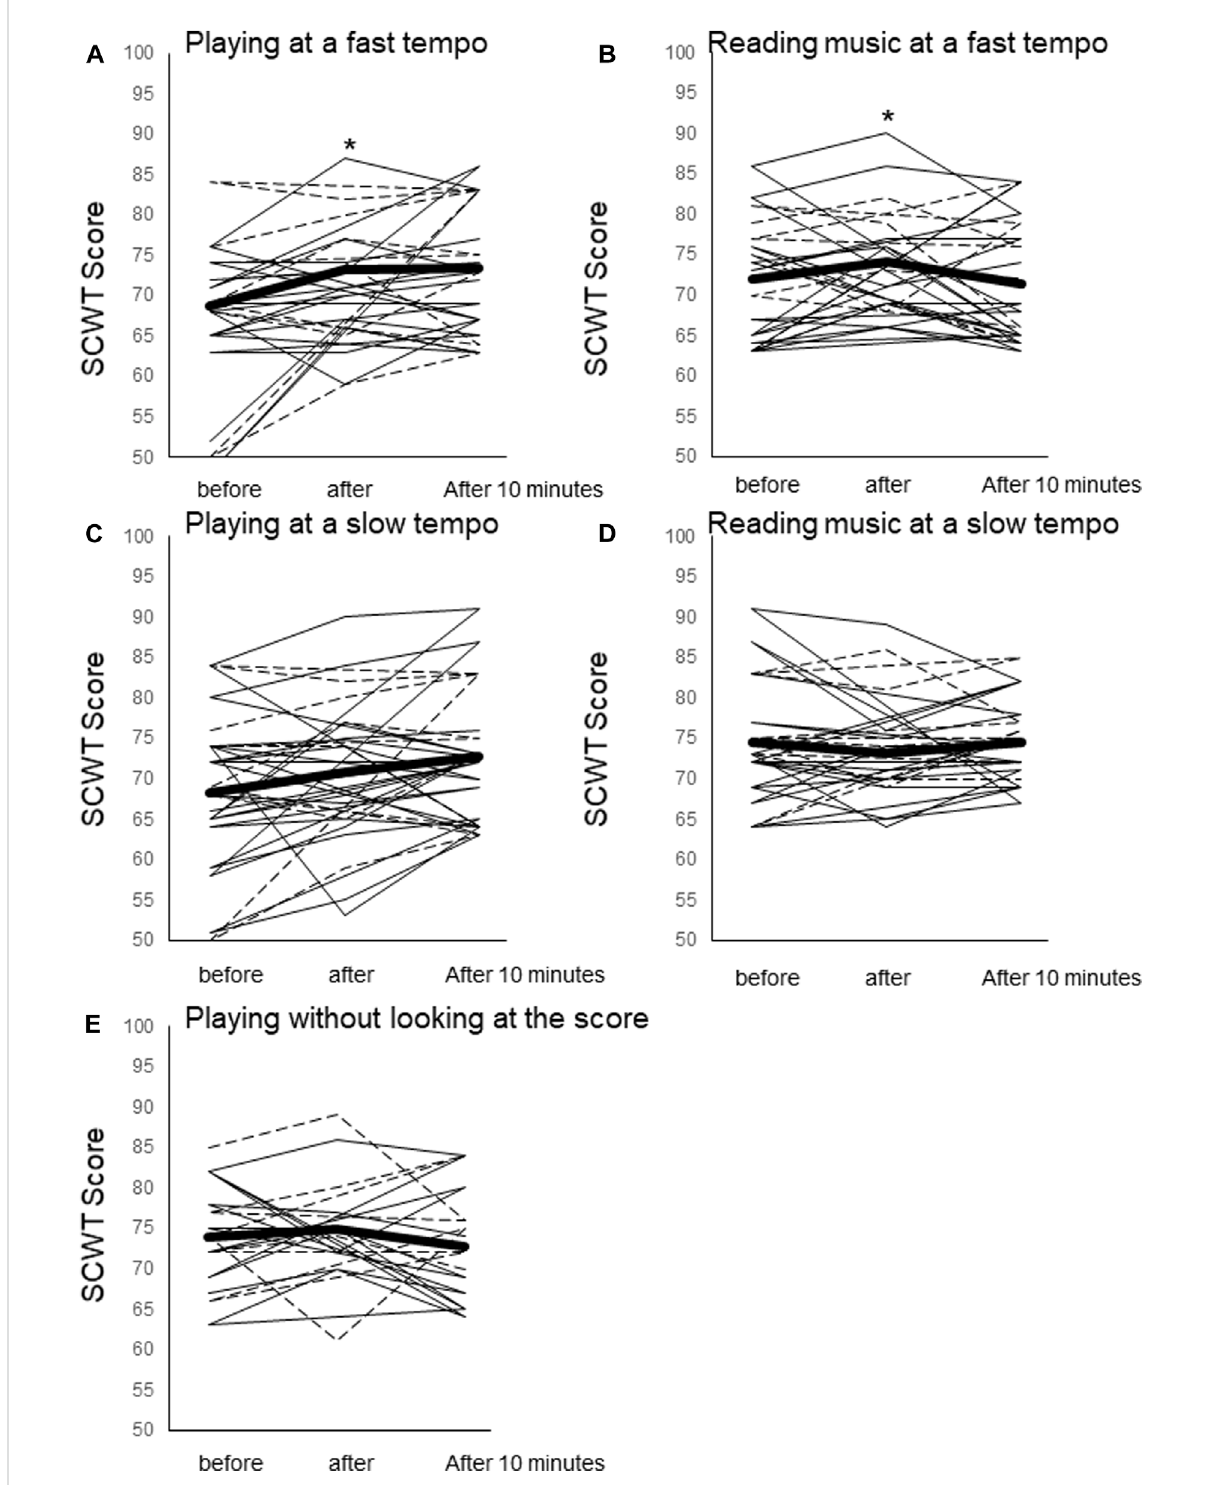
FIGURE 2 Stroop test (SCWT) scores before, immediately after the trial, and 10 min after the trial. (A) Playing at a fast tempo (PL80), (B) reading music at a fasttempo(RE80),playingataslowtempo(PL60),readingmusicataslowtempo(RE60),andplayingwithoutlookingatthemusic(ME).Meanvalues for all participants (thick black line) and individual values for piano players (thin black line) and violin players (dotted line) are shown. *: p < 0.05 vs. resting. † : p < 0.07 vs.